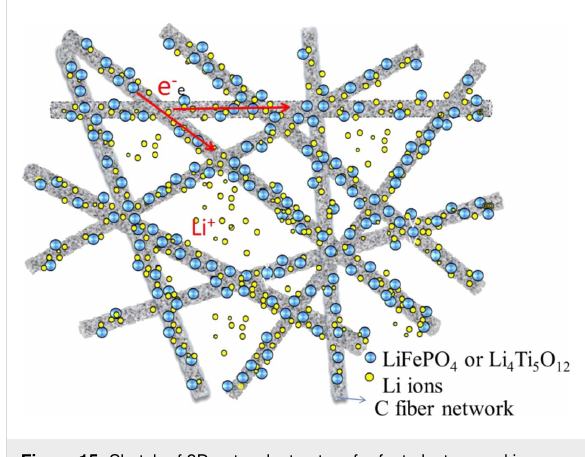
Figure 15: Sketch of 3D network structure for fast electron and ion